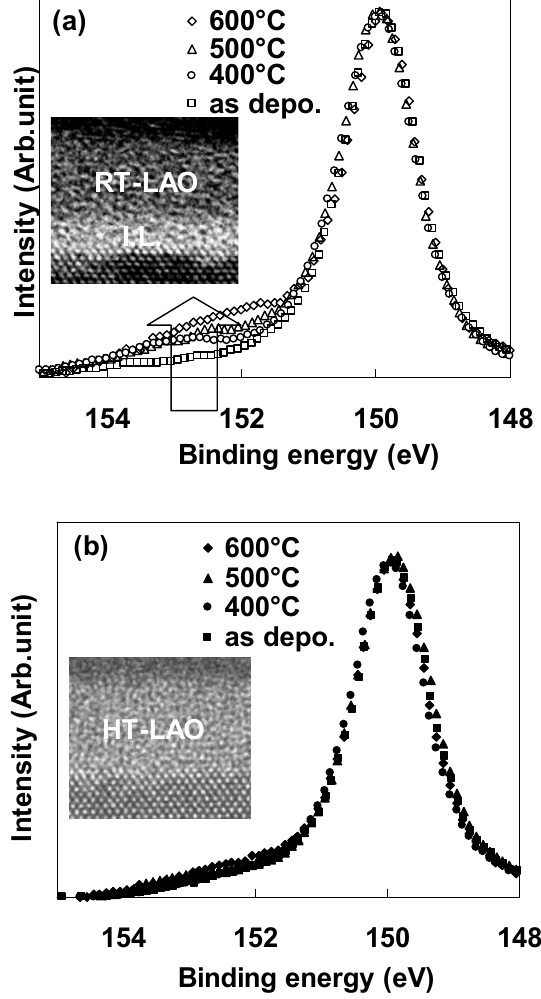
Figure 8. Si 2s XPS spectra for vacuum annealing temperatures ranging from 400 °C to 600 °C for ( a ) RT-LAO and ( b ) HT-LAO. The insets show TEM images after annealing at 400